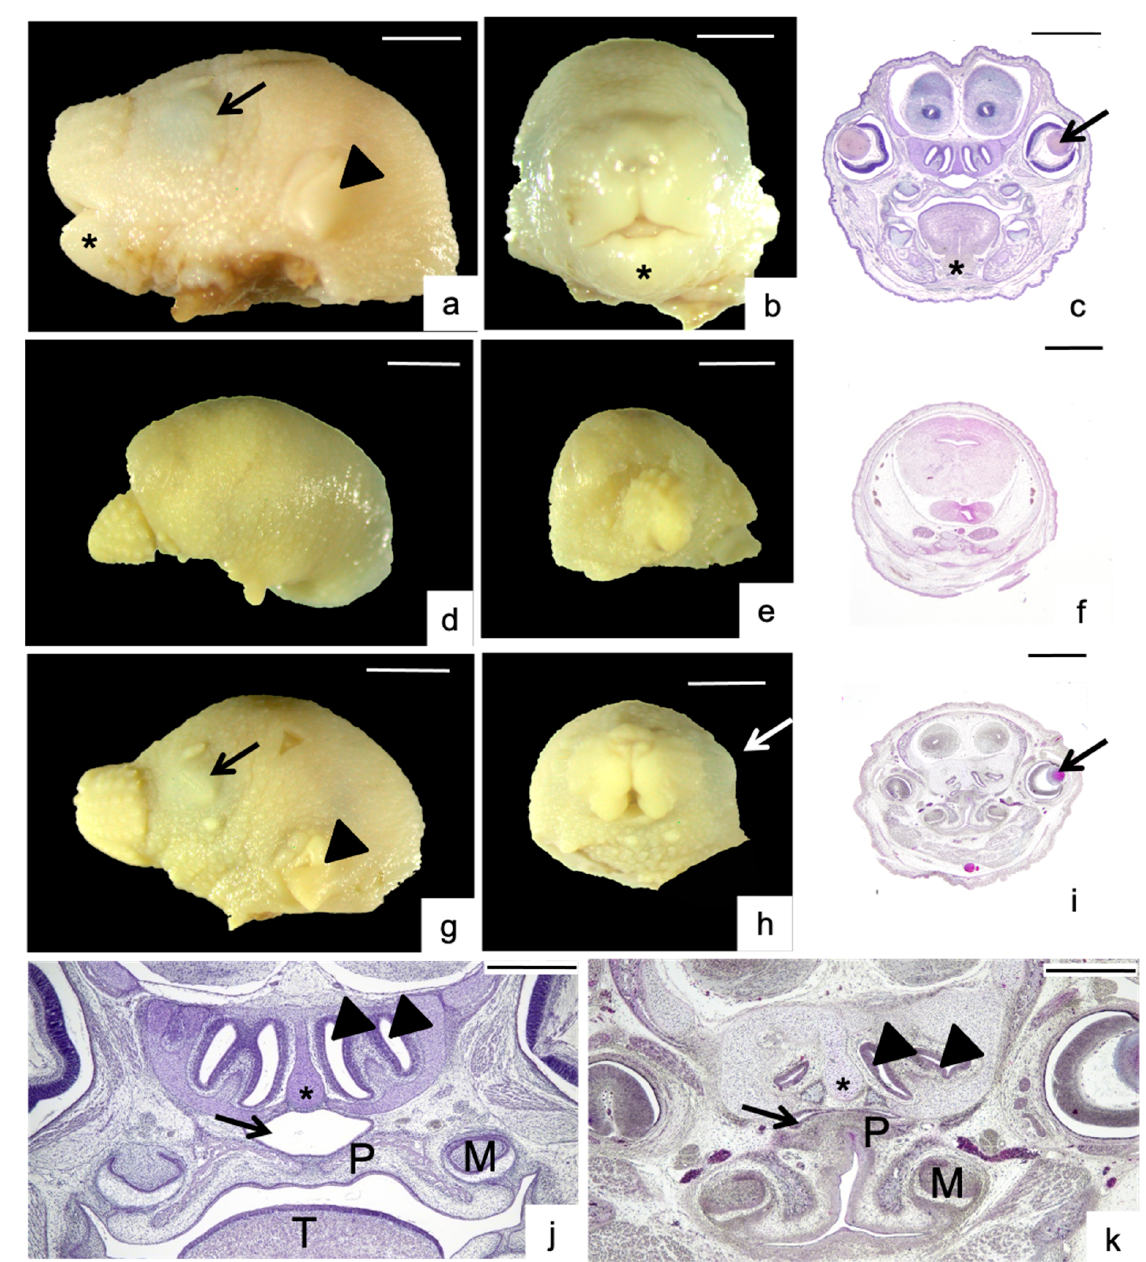
Figure 3. Head and palatine malformations. Control fetus head: lateral view ( a ), frontal view ( b ) and coronal section ( c ). Arrowhead: ear. Arrow: eye. Asterisk: mandible. Severely malformed fetus: lateral view ( d ), frontal view ( e ) and ( f ) coronal section. The eye, ear and mandible were not developed, the palate is not recognized. Malformed fetus head: lateral view ( g ), frontal view ( h ) and coronal section ( i ). This case showed asymmetrical head and high arched palate (HAP), lack of mandible and tongue. Arrowhead: ear. Arrow: eye. Magnification of nasopalatine region of control fetus ( j ): the palate (P) showed a form of truncated pyramid, the nasopharynx was like lips and they were two nasal meatus on each side of the nasal septum. Arrow: nasopharynx. Arrowheads: nasal meatus. Asterisk: nasal septum. Magnification of a malformed fetus ( k ) with HAP palate, aglossia and head asymmetry because the meatus dysmorphology. M: developing molar. T: tongue; Scale bar: ( a – i ) 1 mm; ( j – k ) 500 µm.